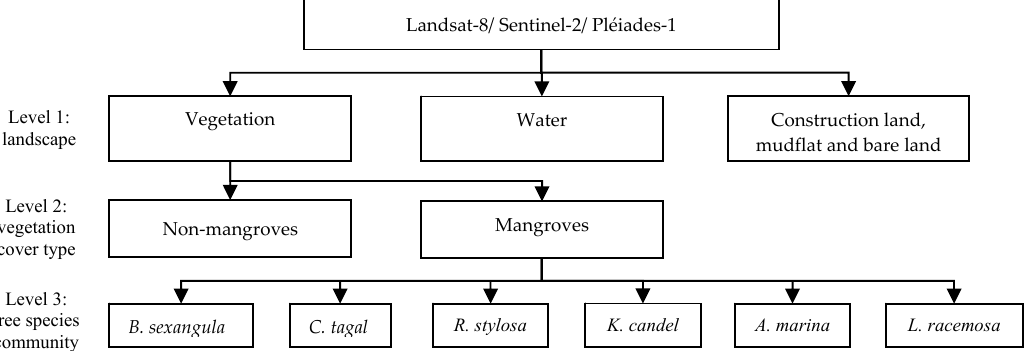
Figure 2. Image object hierarchy for two-scale mangrove feature classifications. Table 3. Two-scale mangrove feature classifications based on Landsat 8, Sentinel-2 and Pléiades-1. MNDWI represents modified normalized difference water index; FDI represents forest discrimination index; WFI represents wetland forest index; MDI2 represents mangrove discrimination index 2; NDWI represents normalized difference water index; NDVI represents normalized difference vegetation index; Red represents the red band; NIR represents the near infrared band; and Seg is an abbreviation for segmentation.